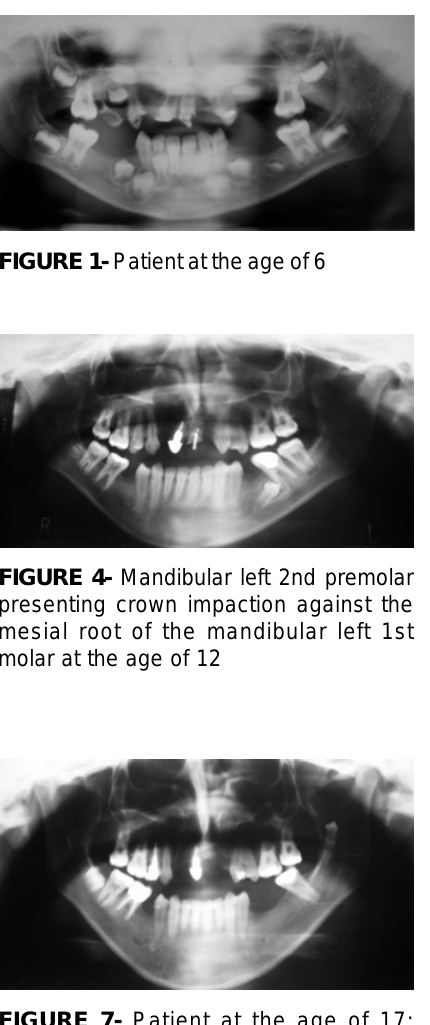
FIGURE 7- Patient at the age of 17: mandibular left 2nd premolar located in the mandibular notch